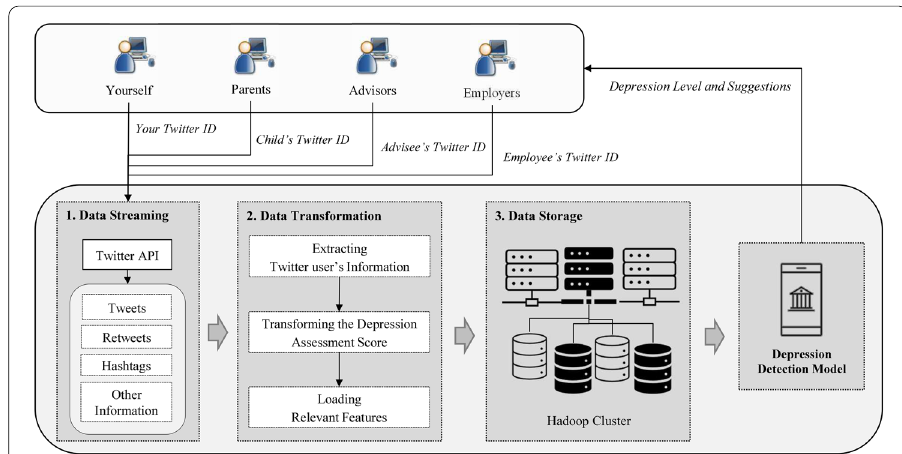
Fig. 1 The process of real-time depression detection